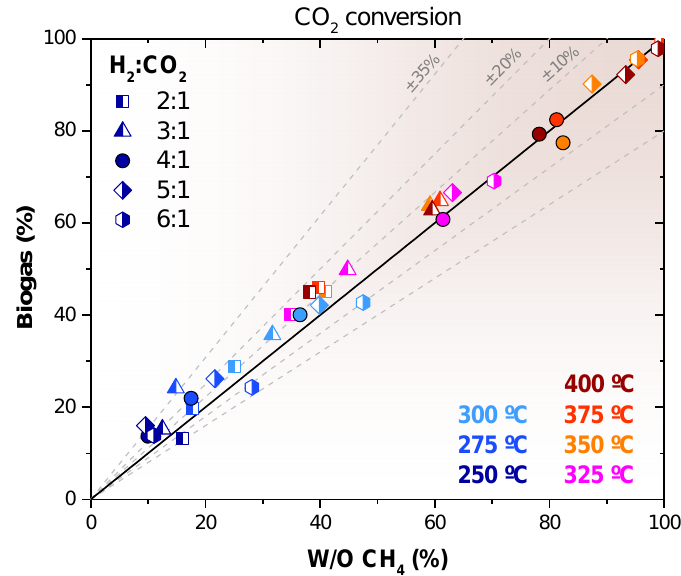
Figure 7. Influence of methane co-feeding on CO 2 conversion (‘Biogas’ vs. ‘W/O CH 4 ’) for ‘3Ru’ catalyst at different temperatures and H 2 :CO 2 molar ratios. Operating conditions (Table 2): q 0 = 250 STPmL·min −1 , H 2 :CO 2 = 4:1, CH 4 :CO 2 = 7:3, and WHSV = 30 × 10 3 (STPmL·g cat −1 ·h −1 ).